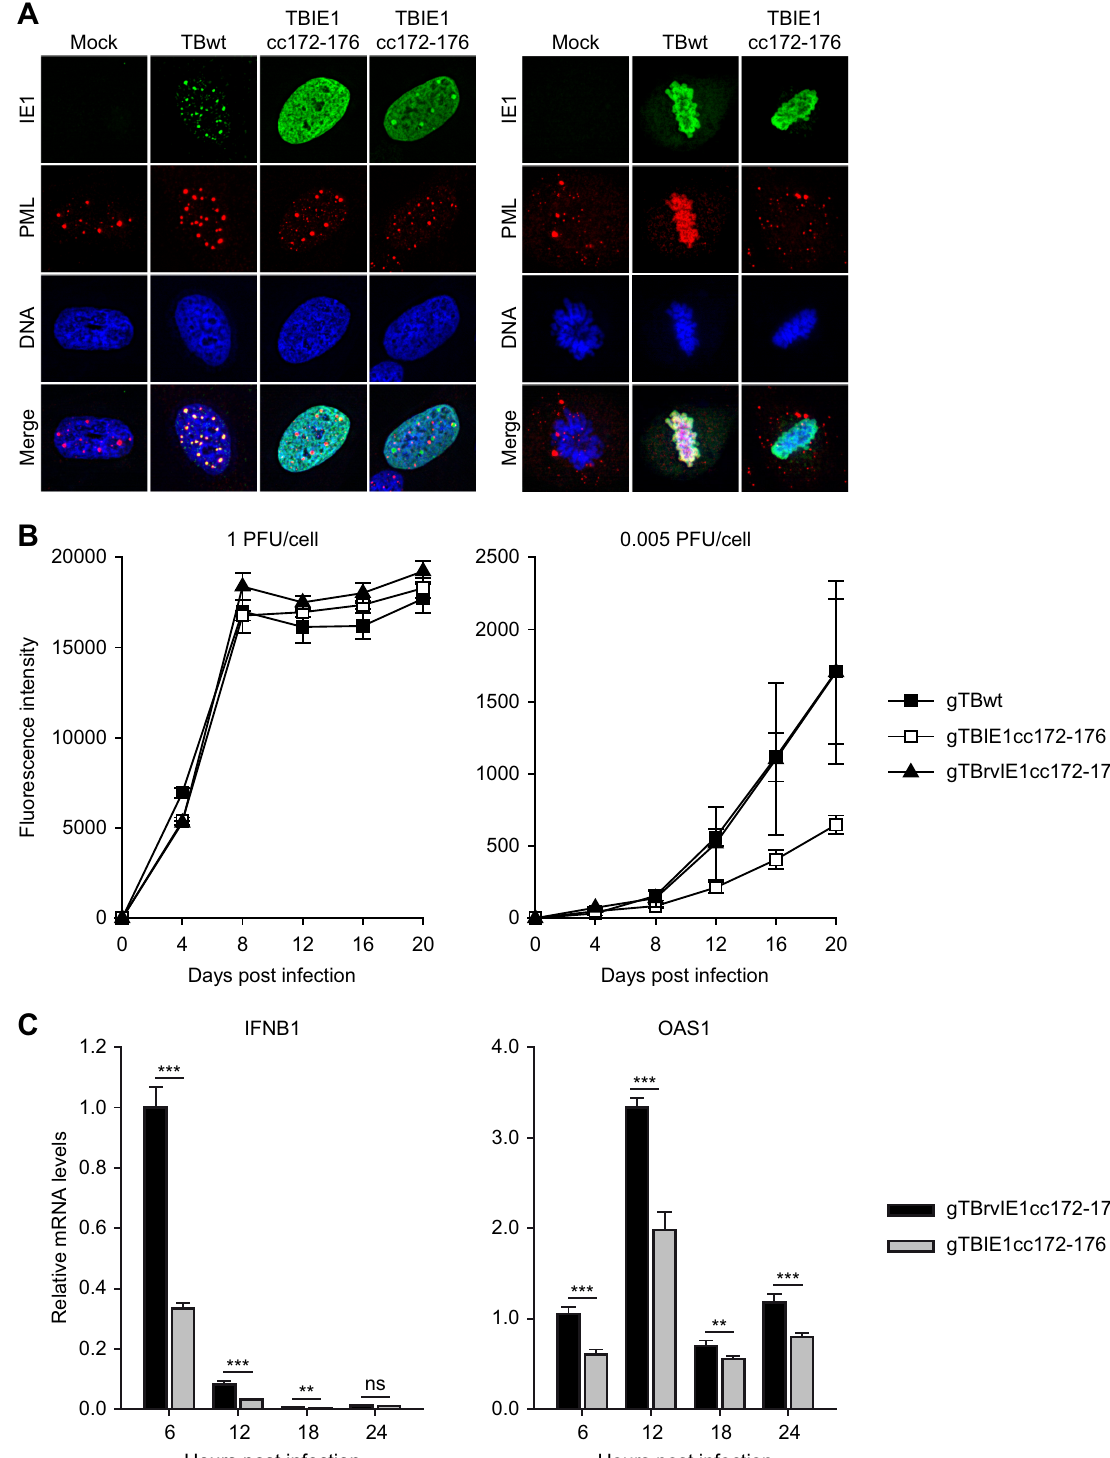
Fig 10. Little attenuation and reduced IFN response in IE1cc172-176 mutant hCMV. (A) MRC-5 cells were mock-infected or infected with hCMV TBwt or TBIE1cc172-176 at an MOI of 0.5 PFU/cell for 24 h. Indirect immunofluorescence staining was performed using mouse anti-IE1 and rabbit anti-PML combined with goat anti-mouse Alexa Fluor 488 and goat anti-rabbit Alexa Fluor 594 antibodies. DAPI was used to stain DNA. Images from interphase (left) or mitotic (right) cells showing the typical localization of IE1 and PML